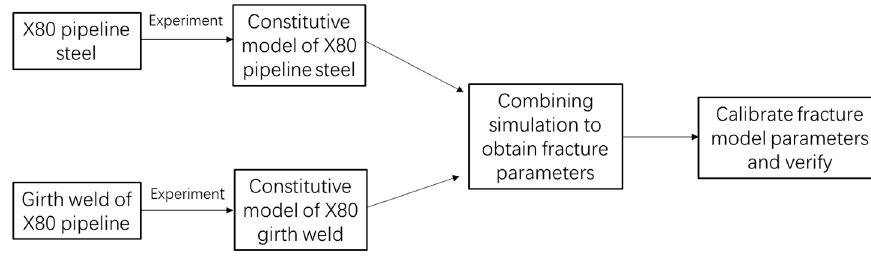
Figure 1. Research flow chart.